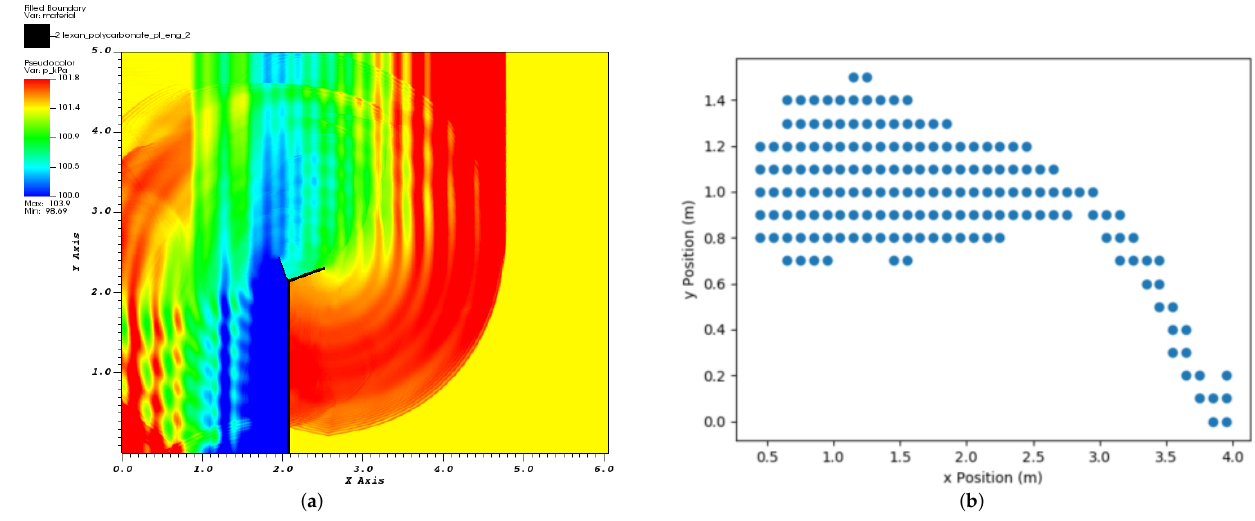
Figure 14. Results from a plane strain analysis of a compound-fairing mitigation barrier loaded by a wave generated from 0.45359 kg of TNT at approximately 36.576 m. ( a ) A snapshot of the wave reflecting over the barrier. The color gradient is set so that max (red) values are above the 0.4516 kPa overpressure threshold. ( b ) The “bubble” behind the barrier for which max overpressure was beneath 0.4516